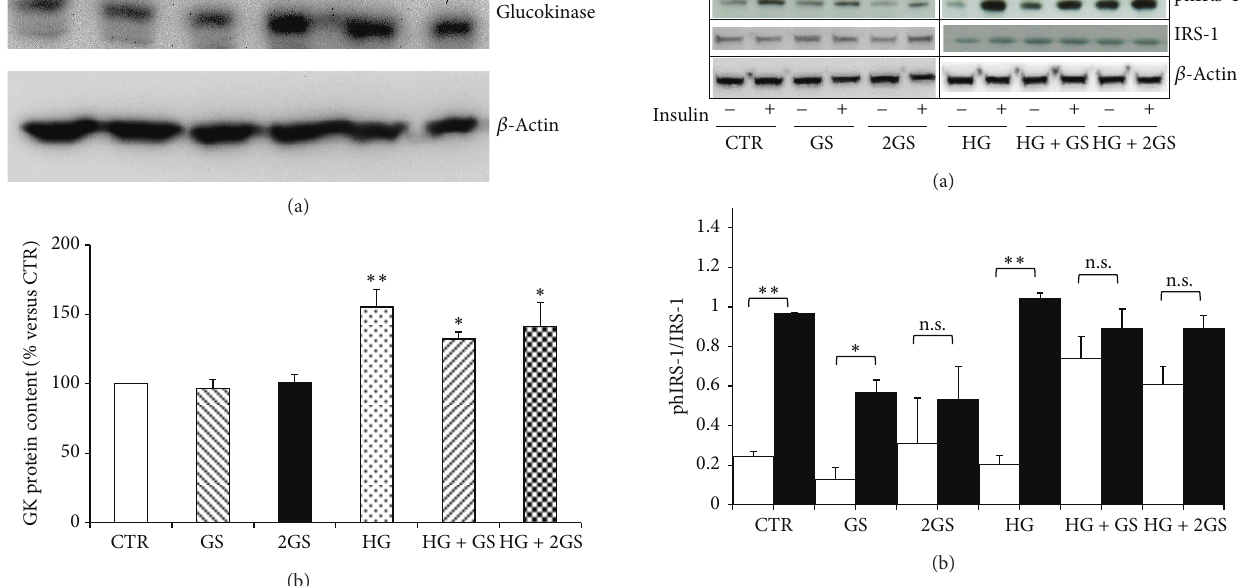
Figure 7: HG increases Glucokinase protein content. (a) Repre- sentative western blot analysis. (b) Quantification of densitometries of western blot bands. Data were expressed as mean ± SE of fold induction relative to 𝛽 -actin ( 𝑛 = 4 ). ∗ 𝑃 < 0.05 and ∗∗ 𝑃 < 0.01 versus CTR.